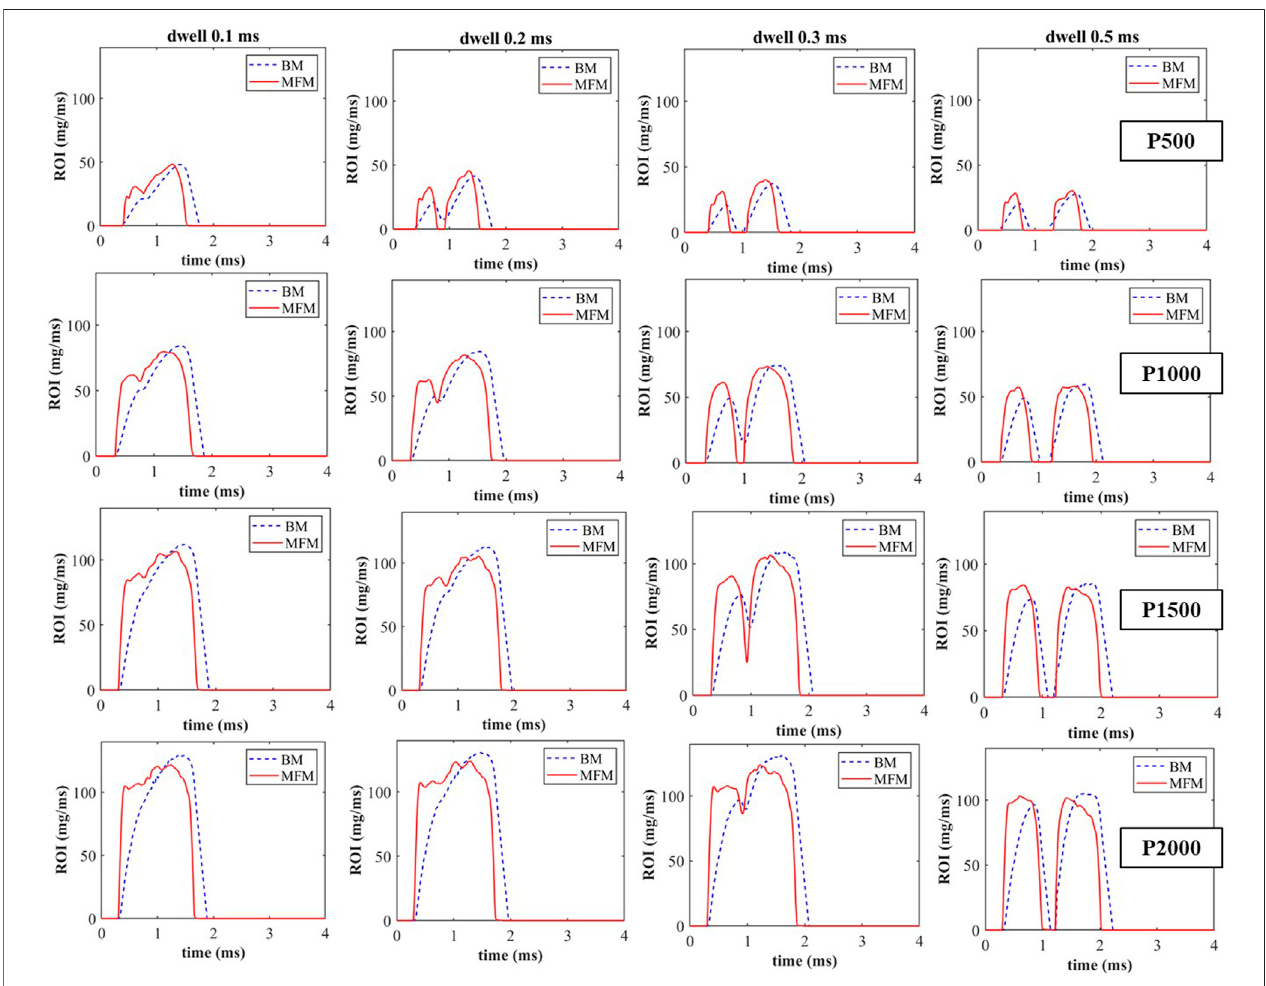
FIGURE 9 | Comparison of ROI measurements of double/split injections performed with BM and MFM at different injection pressures and different dwell times.